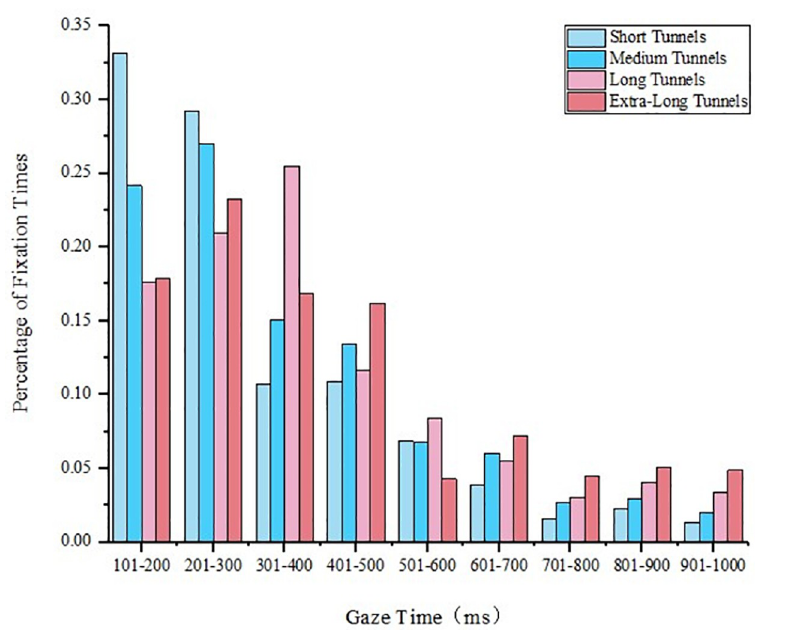
Fig 2. Single-tunnel gaze time zoning statistical